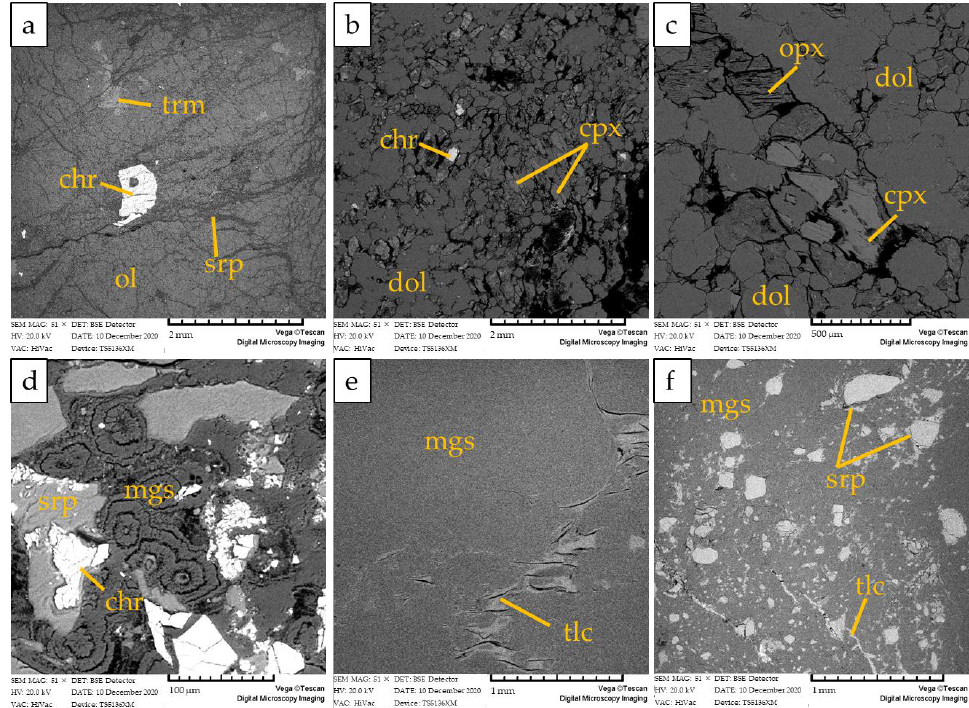
Figure 6. BSE images of ( a ) partially serpentinized peridotite (F4d), showing accessory spinel associated with unaltered olivine, rarely altered into serpentine; ( b ) dolomitized peridotite (F4c) showing euhedral dolomite crystals and rare spinel and clinopyroxene; ( c ) dolomitized peridotite showing euhedral dolomite crystals and subordinate clinopyroxene and orthopyroxene; ( d ) hydraulic breccia (F4b) showing angular serpentine and chromite clasts cemented by magnesite with cockade texture; ( e , f ) massive magnesite (F4a) with minor talc and serpentine clasts. Mineral abbreviations are trm: tremolite, chr: chromite; ol: olivine; srp: serpentine; cpx: clinopyroxene; dol: dolomite; opx: orthopyroxene; mgs: magnesite; tlc: talc.